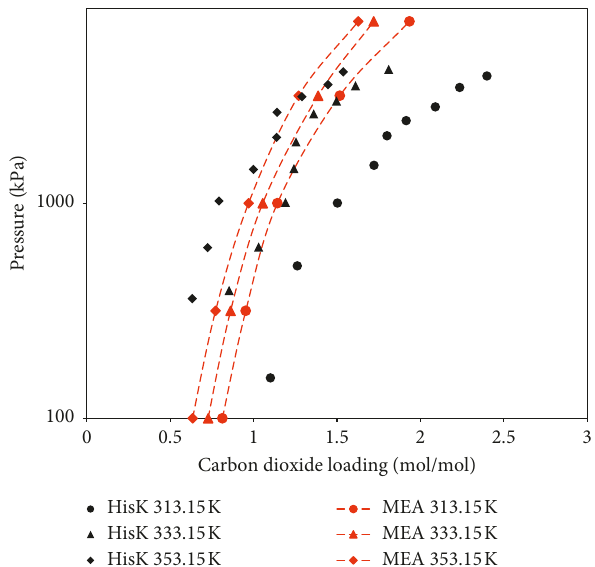
Figure 2: Experimental solubility behaviour of carbon dioxide in 1M aqueous potassium salt of L -histidine and data of 1M mon- oethanolamine [45].